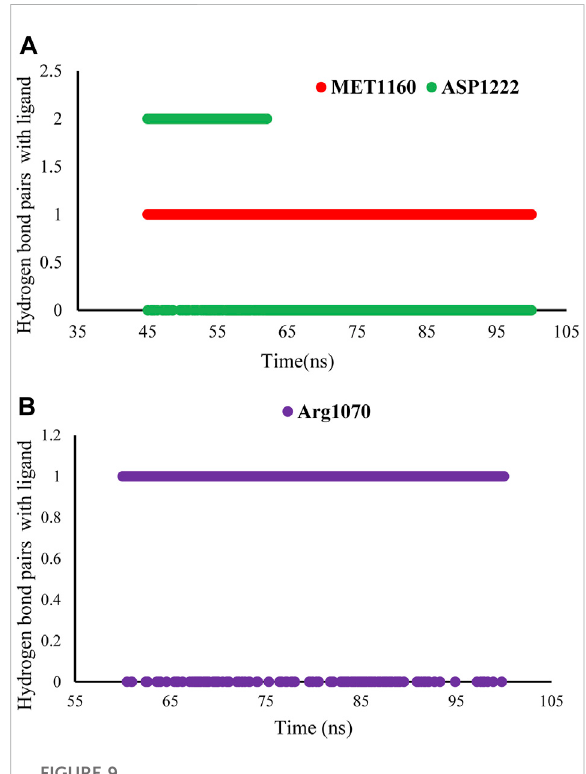
FIGURE 9 Stability of hydrogen bond interactions of compound CM9 with MET and FLT4 (VEGFR3). The stability of hydrogen bond interactions of CM9 derivative in the equilibrium time range and promising residues inside the active site of MET (A) and FLT4 (B) are